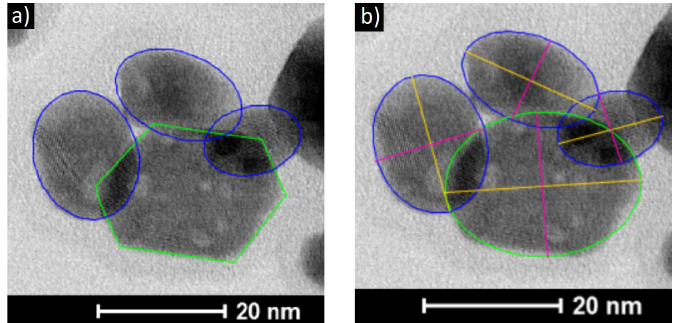
Figure 2. Outlined and approximate in shape individual nanoparticles (blue contours-rounded non- faceted NPs (fine fraction), greenish elongated faceted hexagons of NPs (coarse fraction)) - ( a ); linear dimensions of NPs (yellow axis-large diameter (D) of the ellipse, pink axis-small diameter (d) of the ellipse) - ( b ).